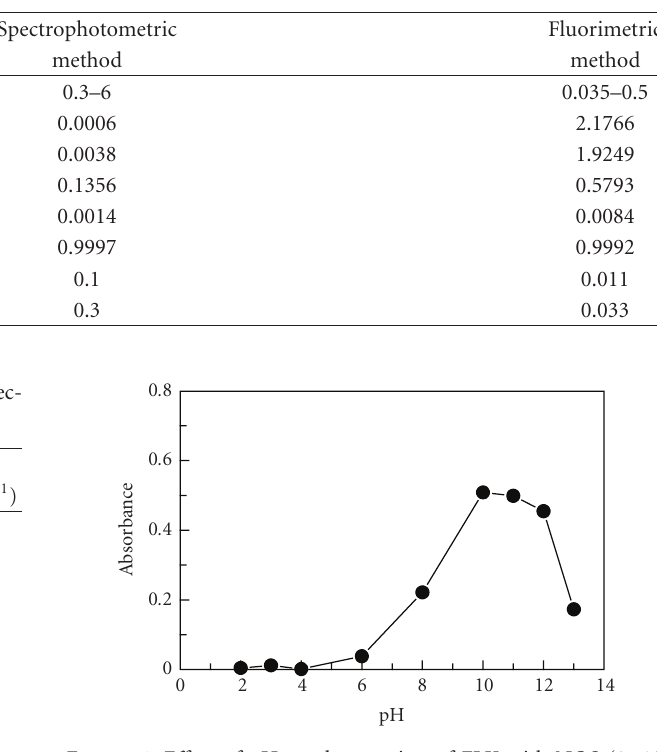
Figure 4: E ff ect of pH on the reaction of FLX with NQS (0.5%, w/v) and NBD-Cl (0.2%, w/v). FLX concentrations were 3 and 0.02 μ gmL − 1 for its reaction with NQS and NBD-Cl, respectively. RFI is the relative fluorescence